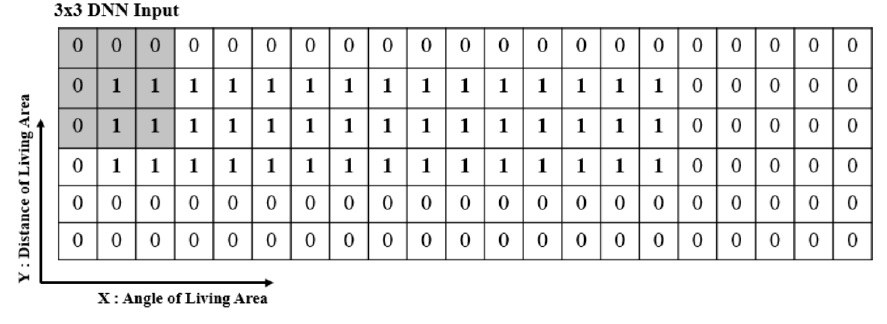
Figure 7. Two-dimensional human detection histogram.